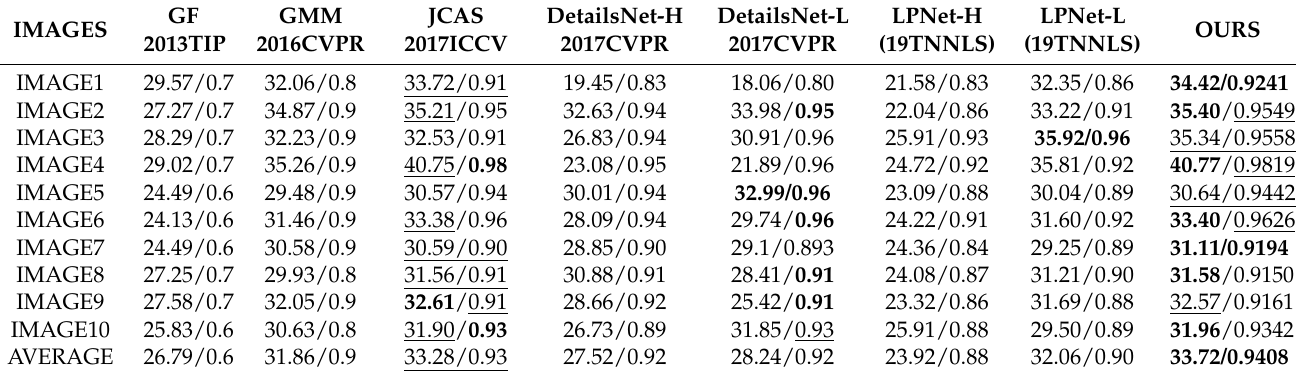
Table 2. PSNR (dB)/SSIM Results of Images after Rain Removal by Different